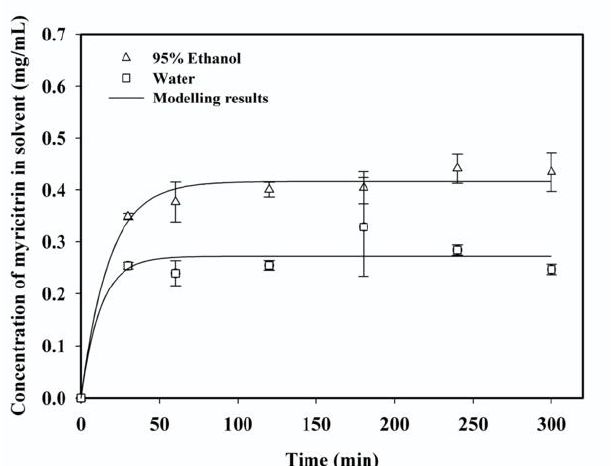
Figure 2. Variation of the myricitrin concentration against the extraction time by using 95% ethanol or water as the solvent. Conditions: DL/solvent = 1/10 (g/mL), UAE at 40 kHz/300 W of ultrasound, 30 °C. Data were expressed as mean ± standard deviations from triplicate experiments. Symbols: experimental data; lines: modelling results.